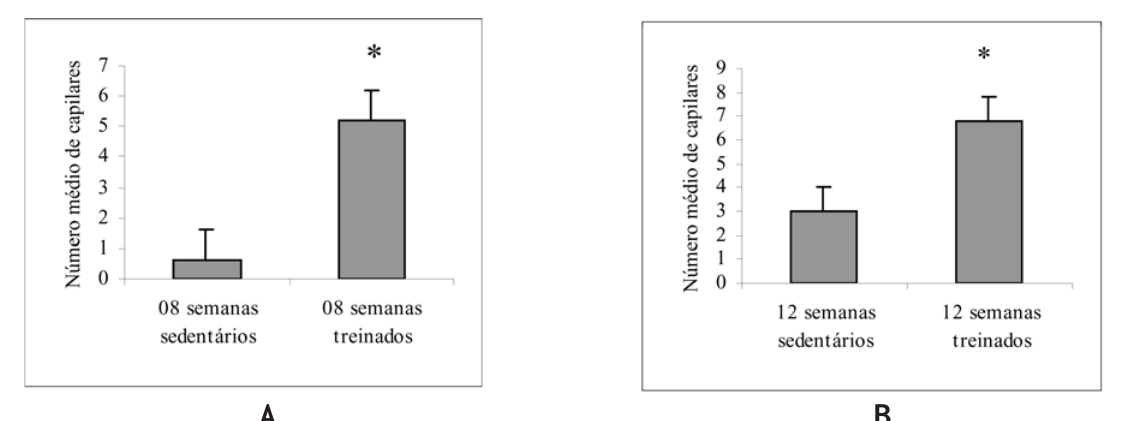
FIGURA 2 - Valores médios do número de capilares no músculo vasto medial direito animais sedentários e submetidos ao treinamento de endurance. A. durante 8 semanas após a ligadura da artéria femoral direita; B. durante 12 semanas após a ligadura da artéria femoral direita. *Relação estatisticamente significante (P < 0,05, para o Teste de